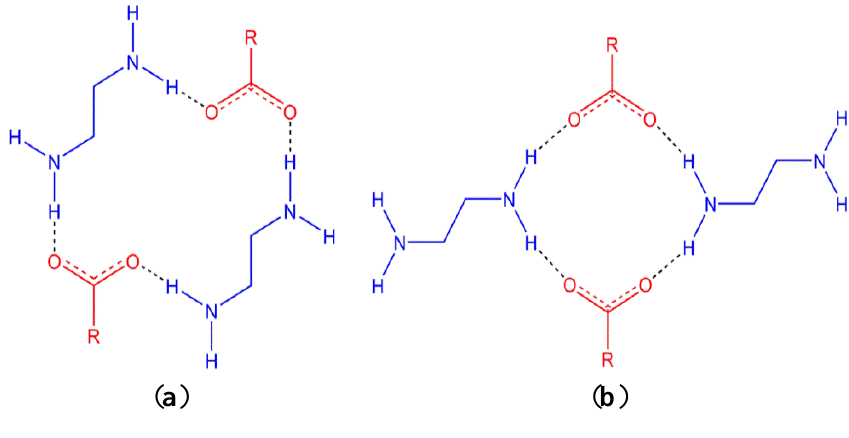
Figure 1. Two hydrogen bonding motifs between piperazinediium and carboxylates; an R ring ( a ) and a smaller R ring ( b ). The protonated piperazine rings are shown side-on for